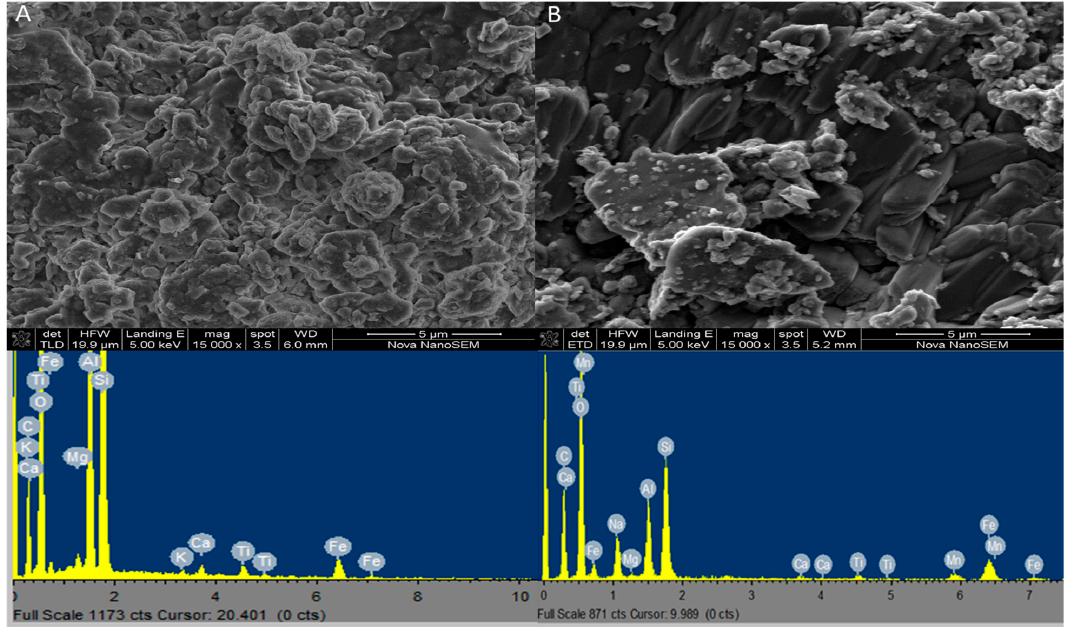
Figure 1. SEM Micrographs and EDS spectrums of raw kaolin (RK) and FMK.